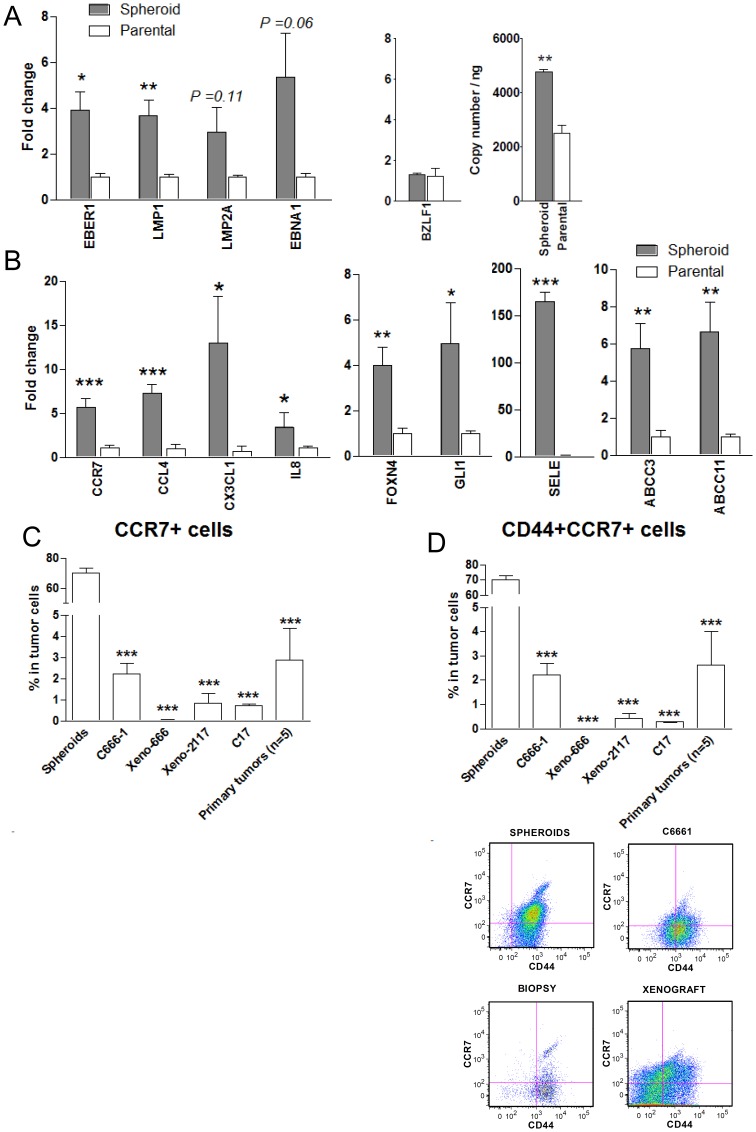
Overexpression of multiple EBV and cellular genes in sphere-forming NPC cells.(A) By qRT-PCR, multiple EBV genes (EBER, BARF1, LMP1, LMP2A, EBNA1 and BZLF1) were found to be overexpressed in spheroids when compared to monolayer C666-1 cells. EBV copy number in these cells was determined by qPCR. (B) Selected genes aberrantly expressed in spheroids were confirmed by qRT-PCR. The significantly upregulated genes include chemokines and receptors (CCR7, CCL4, CX3CL1 and IL-8), cell adhesion molecule SELE, signaling molecules (GLI1, FOXN4) and ABC transporters (ABCC3, ABCC11). (C) Cell surface-expressed CCR7 was found to be frequently expressed in sphere-forming cells (>60%) by flow cytometry. The CCR7+ cell subpopulation was also detected in NPC lines and primary tumors (<5%). (D) CD44+CCR7+cells were also found to be enriched in spheroids. Histograms denoting mean ± SE (n≥3) with statistical significance calculated by t-test (*P<0.05, **P<0.01, *** P<0.001).